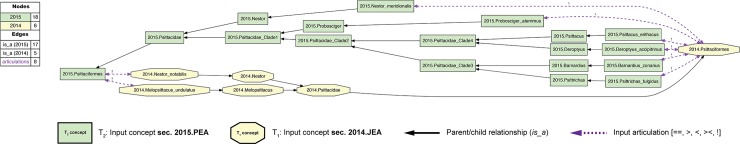
Input visualization for the 2015./2014.Psittaciformes alignment, with coverage globally applied.In all toolkit visualizations, the input and aligned, non-congruent concepts sec. 2015.PEA are shown as green rectangles (T2−18 concepts). Input and aligned, non-congruent concepts sec. 2014.JEA are shown as yellow octagons (T1−6 concepts). Congruent sets of aligned, multi-sourced concepts (first shown in Fig 4) are rendered in gray rectangles with rounded corners. In this input visualization, each phylogenomic tree is separately assembled via parent/child (is_a) relationships (solid black arrows). All species-level concepts sec. 2015.PEA and 2014.JEA are exclusive of each other. Under strict application of the coverage constraint, this is represented by asserting eight articulations (dashed magenta arrows) of disjointness (!) of each species-level concept from the other-sourced order-level concept. The legend indicates the numbers of nodes and edges for each input tree, parent/child relationships, and expert-asserted input articulations. See also S1 File.